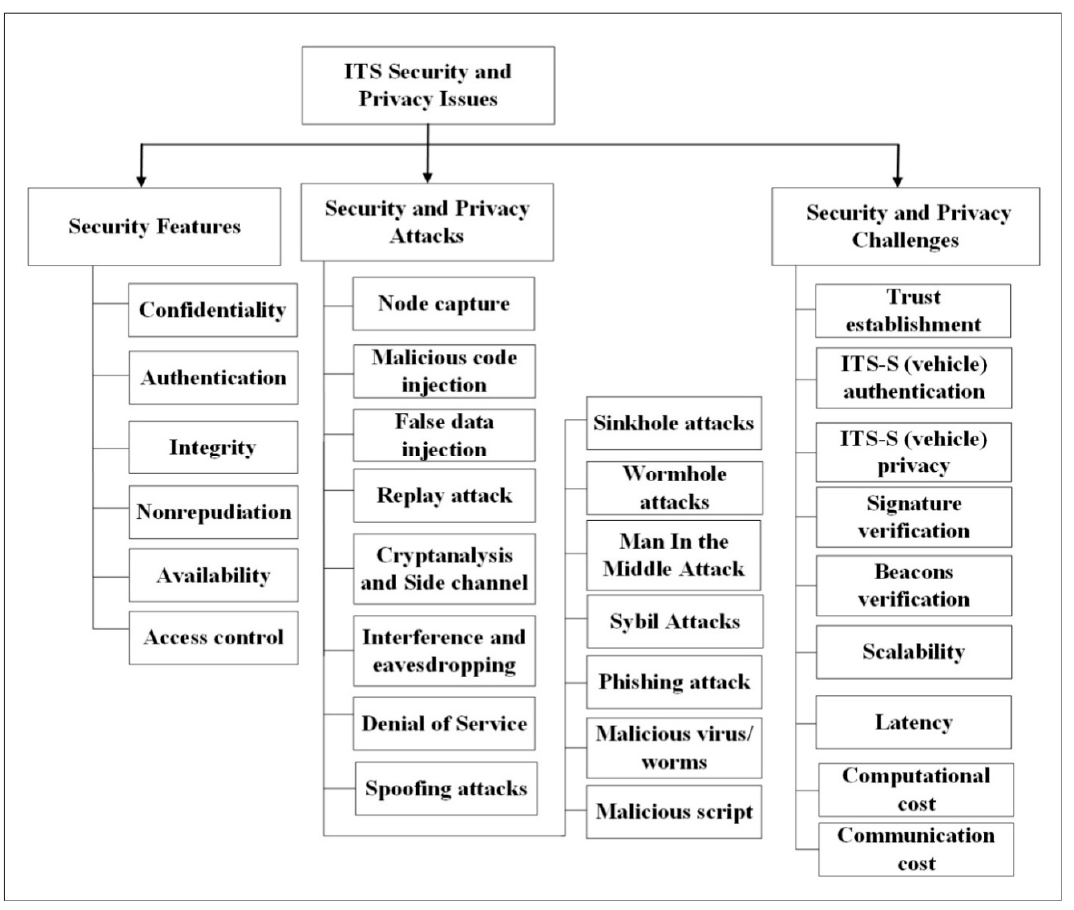
Figure 5. ITS security and privacy issues.